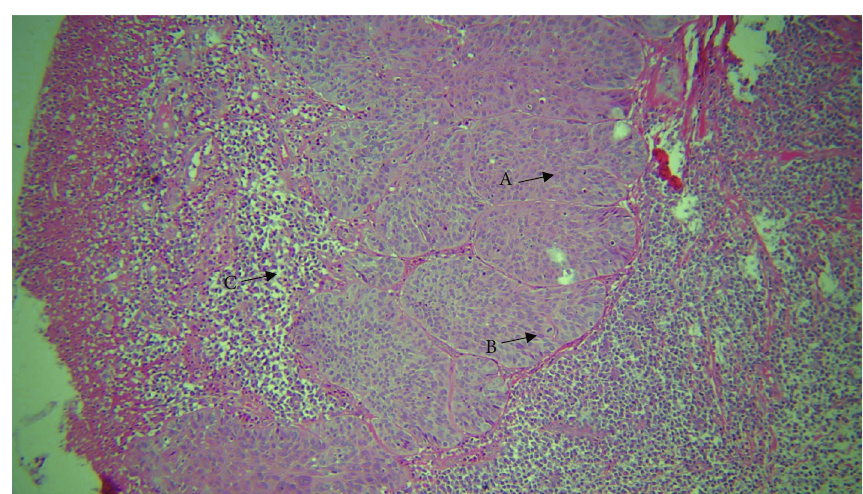
Figure 3: 10 × view. A: basaloid cells; B: mitotic fi gure; and C: in fl ammatory